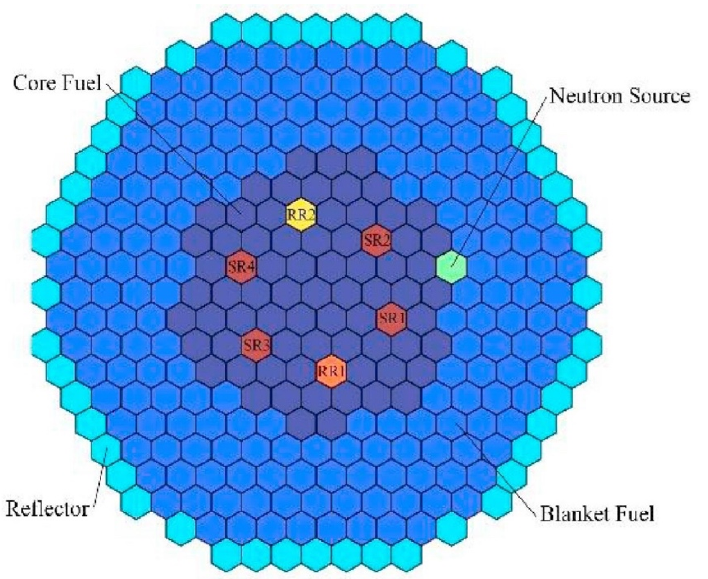
Figure 2. Radial layout of control rod worth calculation.